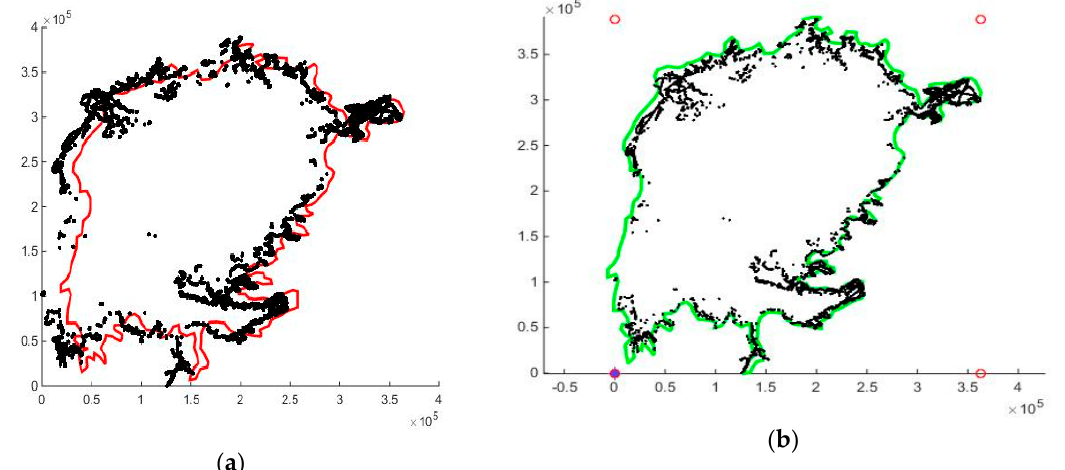
Figure 7. Adjustment of shoreline points: ( a ) Original data (red curve); and ( b ) adjusted by bi-linear transformation (green curve).